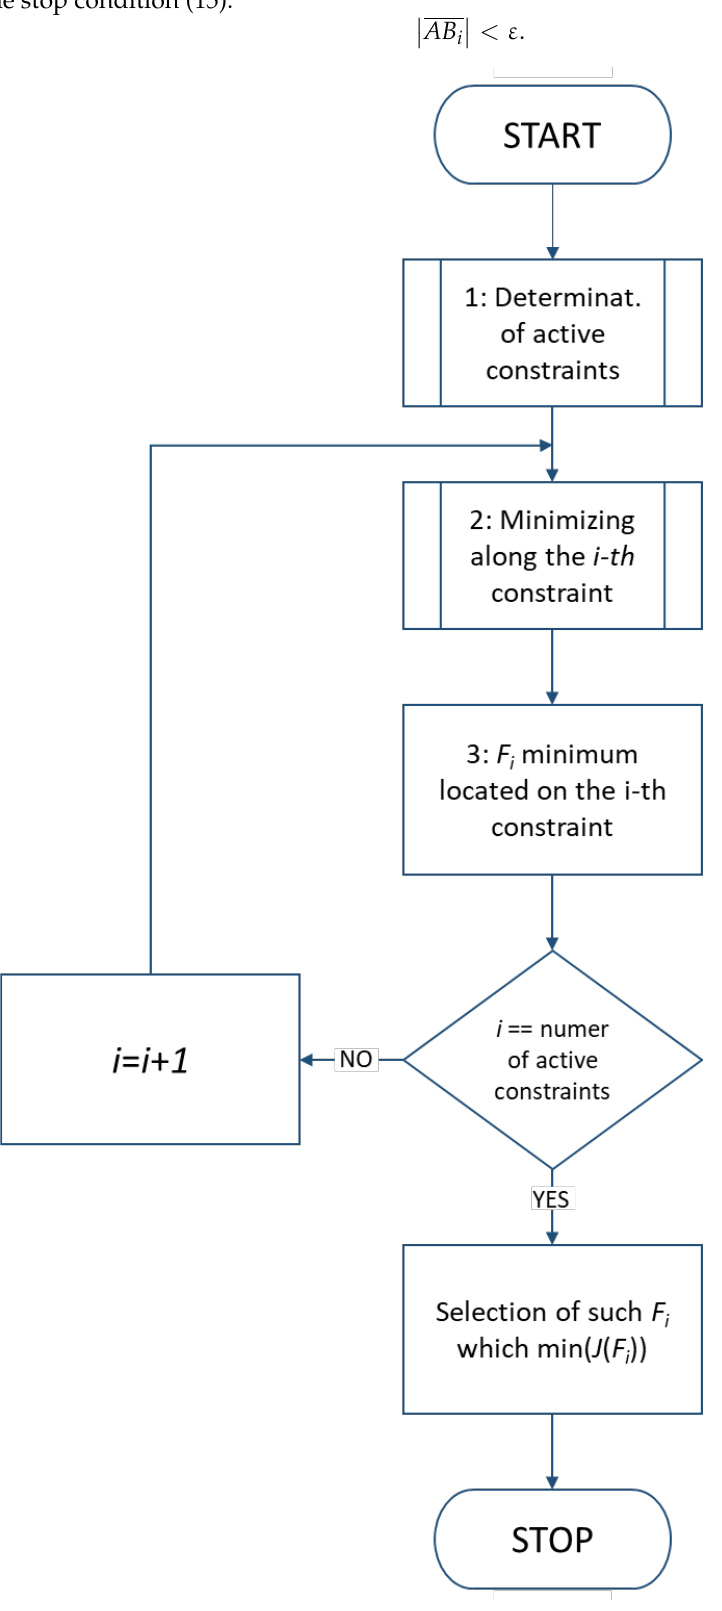
Figure 11. General form of the optimization algorithm.